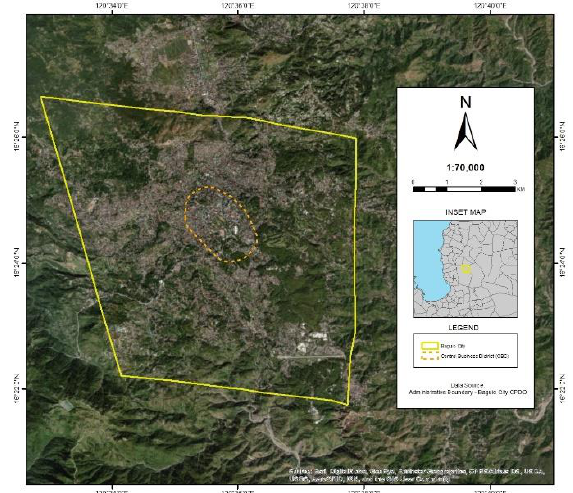
Figure 1. Map of Baguio City in northern Luzon, Philippines